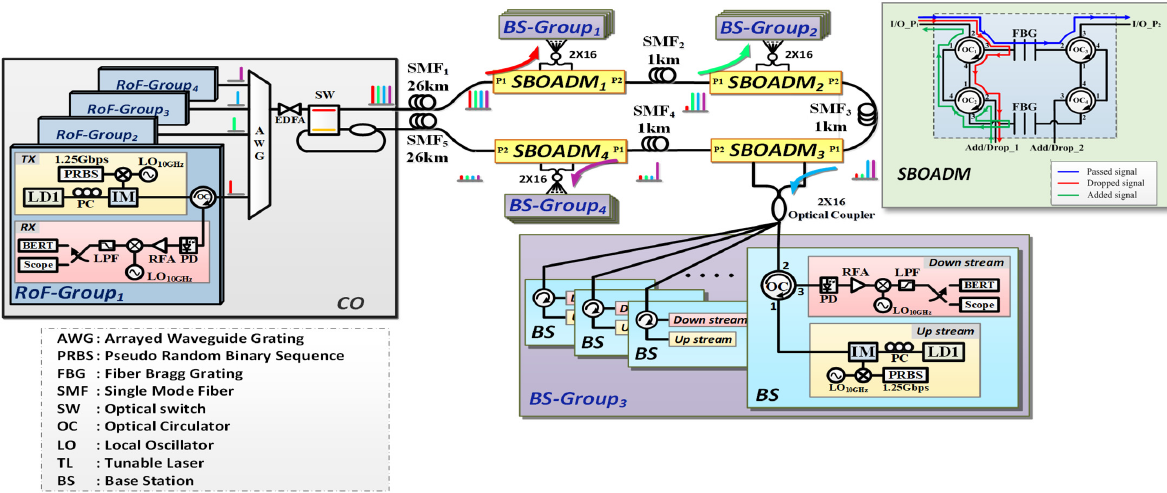
Figure 1. H ybrid ring- and tree-topology RoF transmission system with self-disconnection protection. Figure 1. Hybrid ring- and tree-topology RoF transmission system with self-disconnection